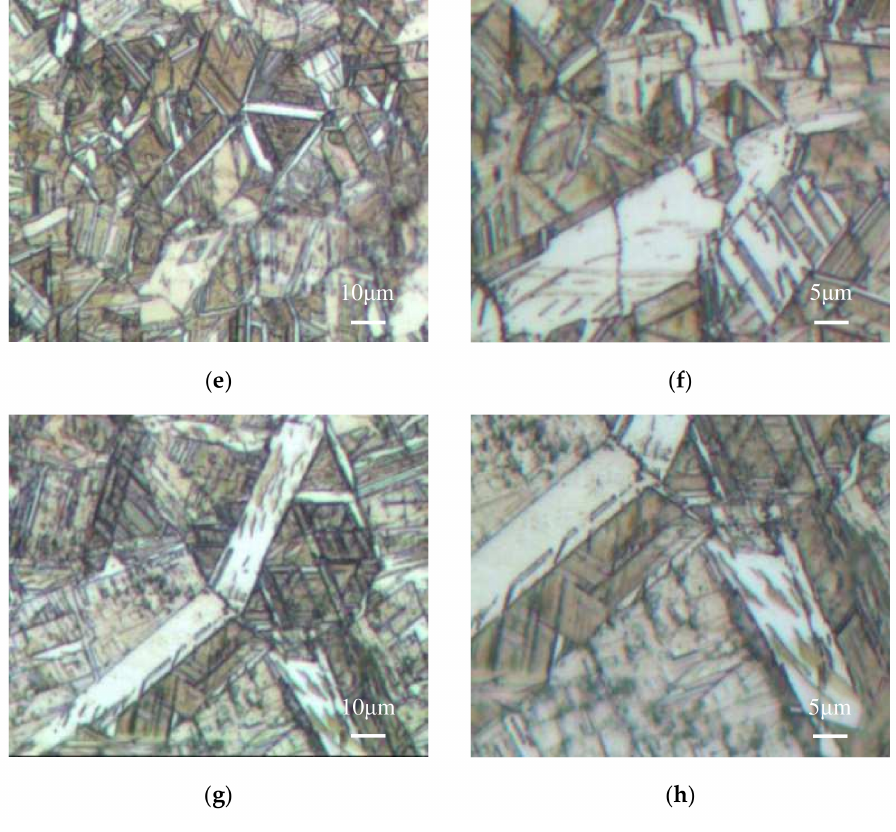
Figure 6. The microstructure of Fe-22Mn-12Cr-4Co-0.2Nb alloy in different annealing states: ( a , b ): forging without annealing; ( c , d ): 800 ◦ C; ( e , f ): 900 ◦ C; ( g , h ): 1000 ◦ C.